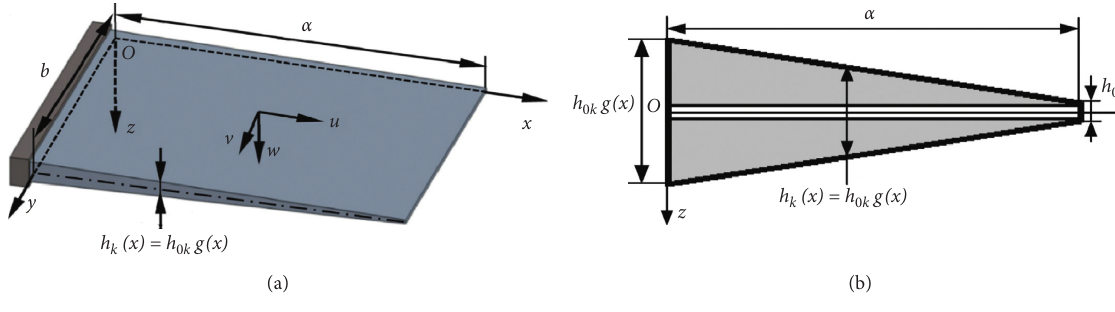
Figure 1: (a, b) Plate of variable